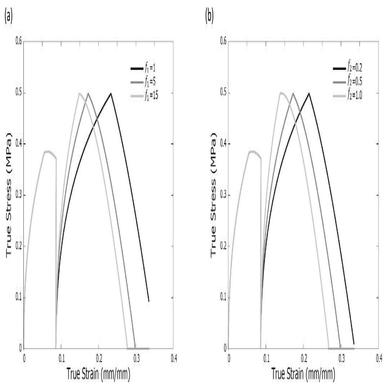
Effect of 1 and 2 on the reloading curves: (a) effect of 1 when 2 = 0.5; (b) effect of 2 when 1 = 5.